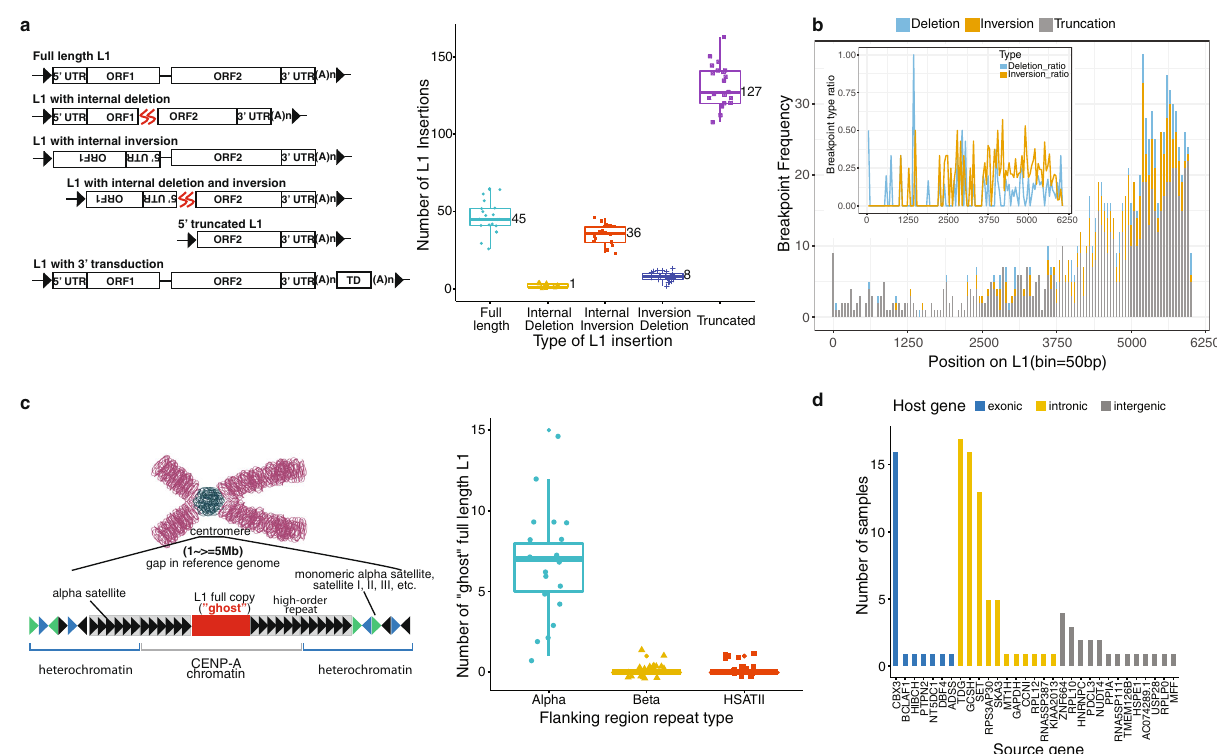
Fig. 4 L1 and processed pseudogene insertion from long reads. a Left is the scheme of different types of L1 insertions, including the full-length L1, L1 with internal deletion, L1 with internal inversion, L1 with both internal deletion and inversion, 5 ’ truncated L1 and L1 with transduction. The boxplot at right shows the number of detected L1 insertions of those 5 types for the 20 long-read samples. b We checked the internal deletion, internal inversion, and truncation breakpoint frequency by position on L1 for all the detected non redundant L1 insertions. More internal deletions, internal inversions, and 5 ’ truncations happen at the tail side. The inset fi gure shows the normalized ratio for internal deletion and inversion by position, which indicates higher inversion rates than deletion from position ~4000 to the end. c Left is the scheme of centromere full-length L1. Right is the number of centromere ‘ ghost ’ full-length L1 copies per sample. On average per sample, we detected about 7, 1, and 1 full-length L1 copies fl anked with Alpha, Beta, and HSATII satellite repeats, respectively. d 31 pseudogene insertions were detected from the 20 samples, including 7, 11, and 13 pseudogene insertions falling within exonic, intronic, and intergenic regions, respectively. 20 (64.52%) of the insertions are only detected in one sample. For the boxplots in a and c , the box demarcations represent the 25, 50, and 75th percentiles, and the whiskers extend from the box to the largest and smallest data points at most 1.5 times the interquartile range away from the